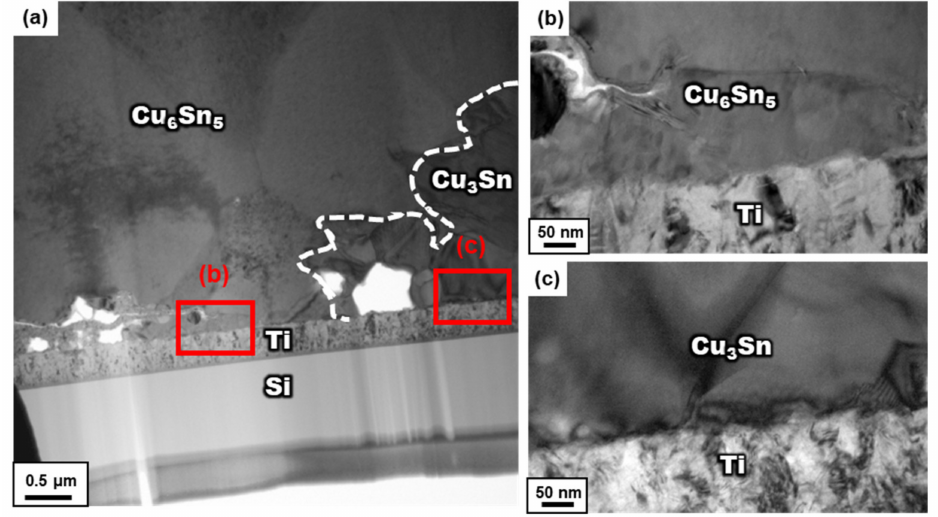
Figure 6. The TEM observation of the micro-bump aging after 42 h in ( a ) the region at the interface between Cu–Sn IMCs and Ti layer, and the enlarged view into the ( b ) Cu 6 Sn 5 interface and ( c ) Cu 3 Sn interface from ( a